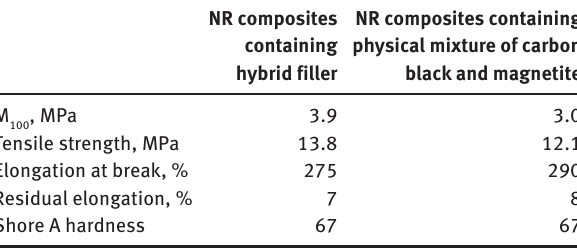
Figure 10: X-ray diffraction pattern of the obtained hybrid filler.